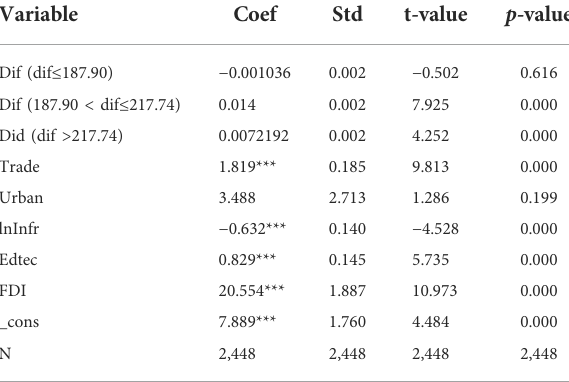
TABLE 11 Result of threshold model regression.